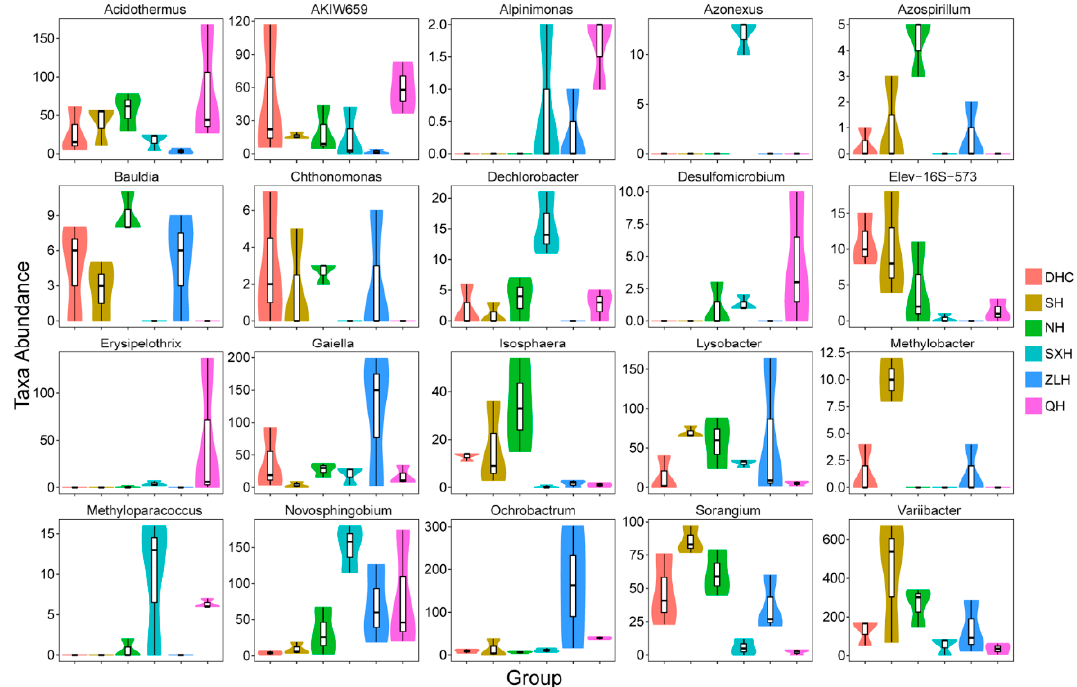
Figure 6. Taxa abundance of different bacteria species in groups DHC, SH, NH, SXH, ZLH and QH, which sampled from sludge.